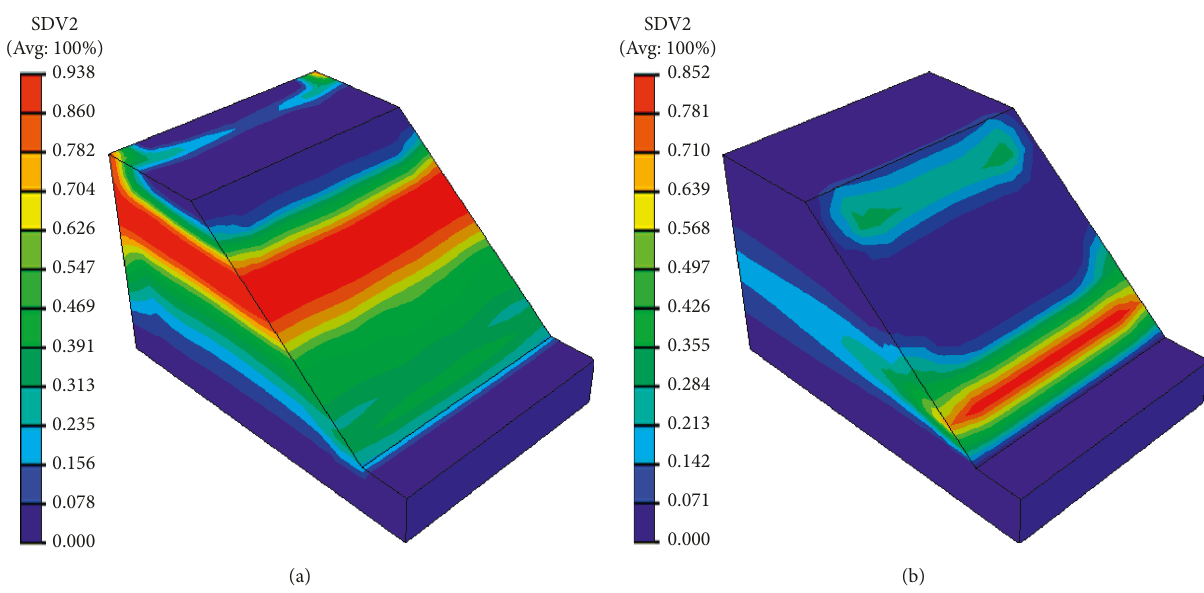
Figure 12: Finite element liquefied area of slope. (a) Natural slope without vegetation. (b) Hinged block of